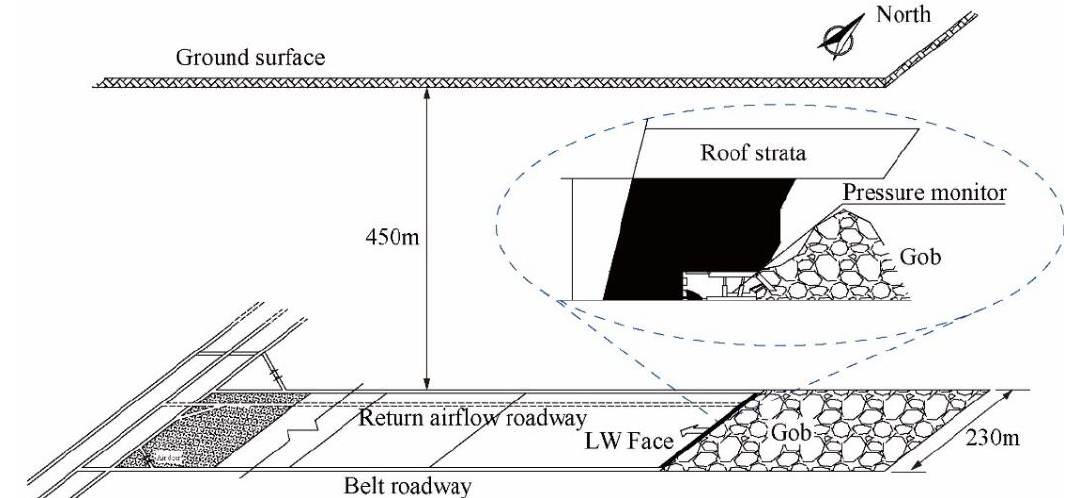
Figure 12. Field measurement diagram in Tashan Coal Mine.